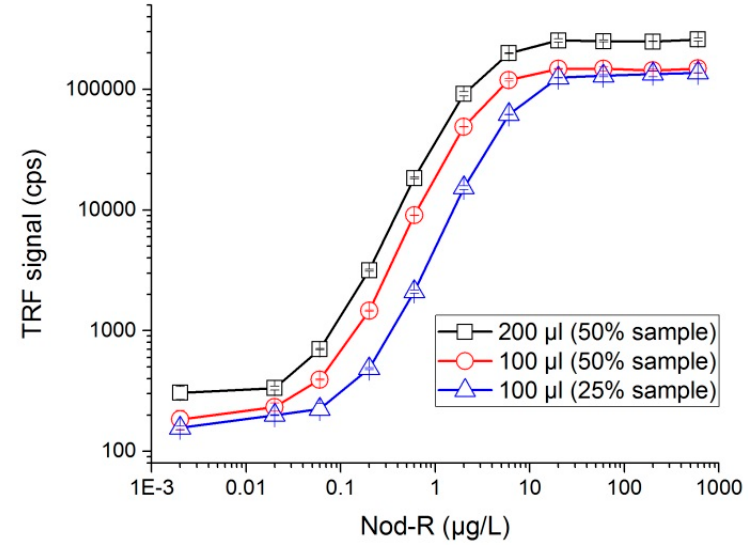
Figure 3. The dose-response curves for the single-step non-competitive assay with different reaction volume. Each data point represents the average of duplicate measurements and the standard errors of the means are shown with error bars. TRF: Time-resolved fluorescence. Cps: counts per second.